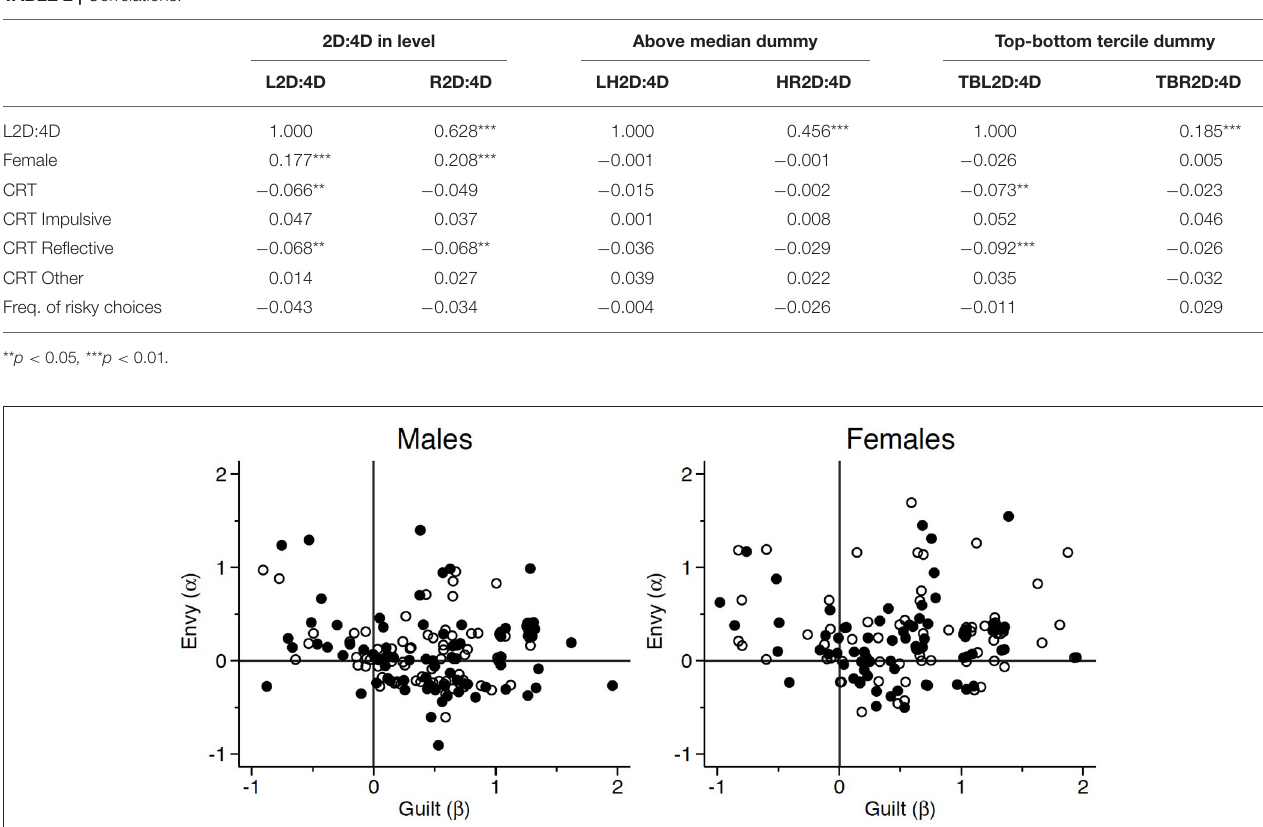
TABLE 2 | Correlations.